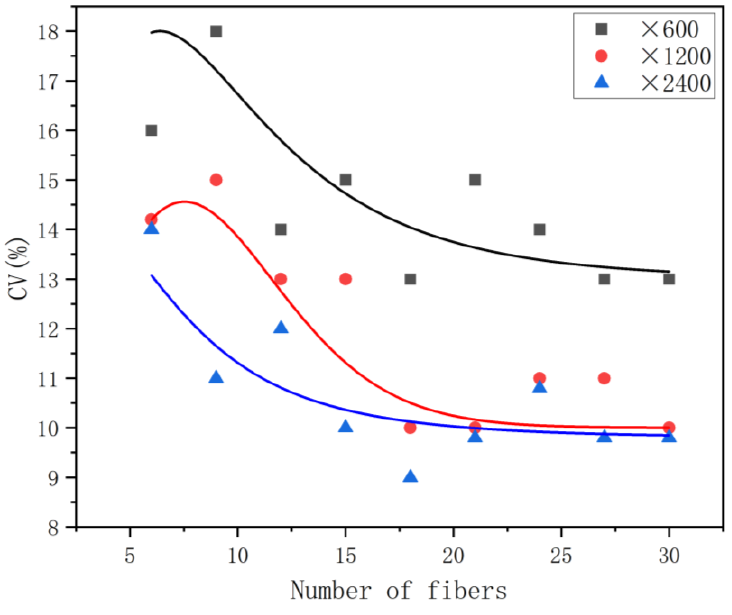
Figure 6. Influence of magnification on the CV Value of side-by-side bicomponent fibers. Table 1. Allowable deviation rate of linear density of the chemical fiber in relevant standards ( E , %).